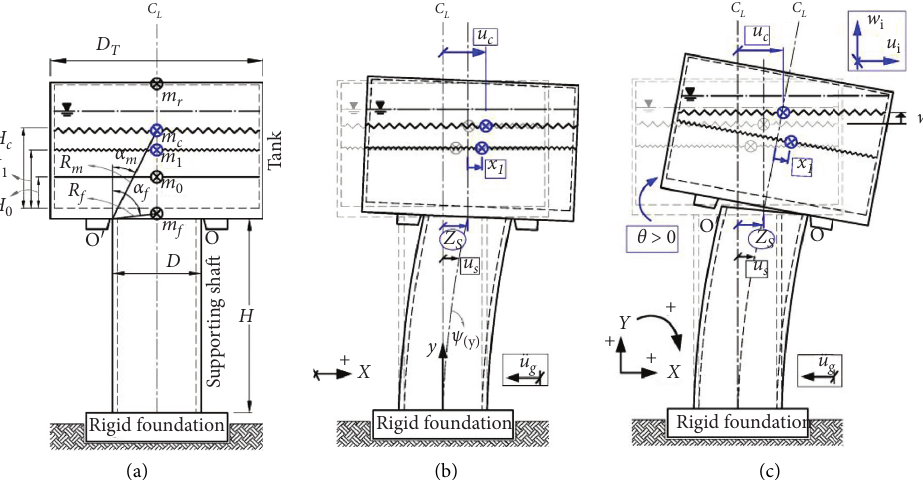
Figure 3: Configuration of rocking elevated tank model with isolation under the tank (C2): (a) initial position; (b) preuplift phase of motion; (c) under rocking motion.